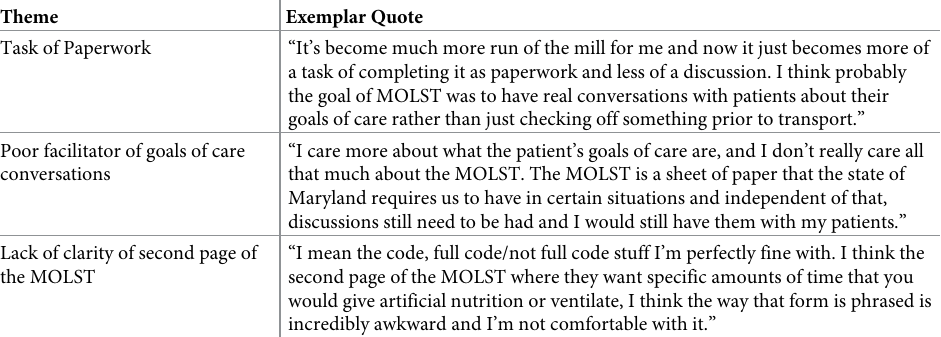
Table 4. Characteristics of MOLST leading to lack of physician